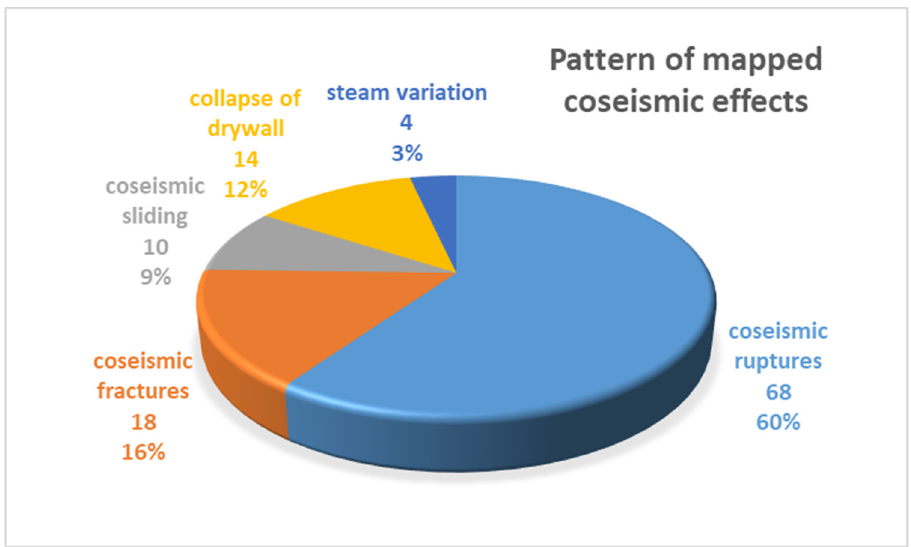
Figure 4. Diagram shows the pattern (number and percentage) of primary, secondary coseismic ground effects and collapse of drywall (data reported because located in the immediate vicinity of ground effects) mapped in the epicentral area immediately after the 21 August 2017 earthquake. Data from Table